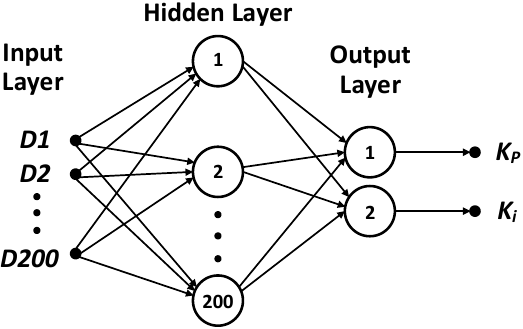
Figure 10. The artificial neural networks (ANN) model.